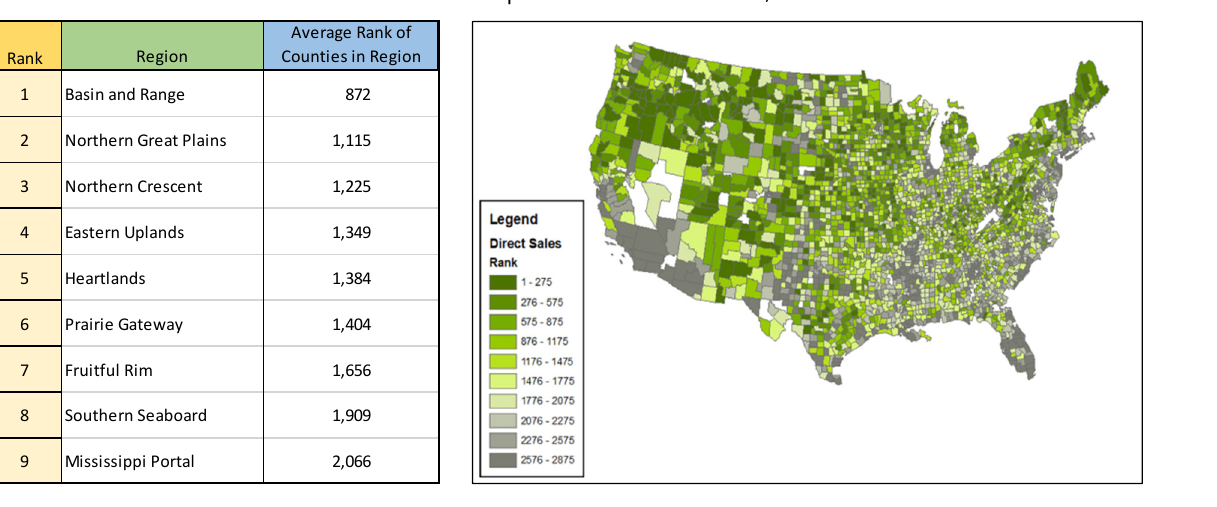
Table 11. Region Ranking: Direct Sales, 2012